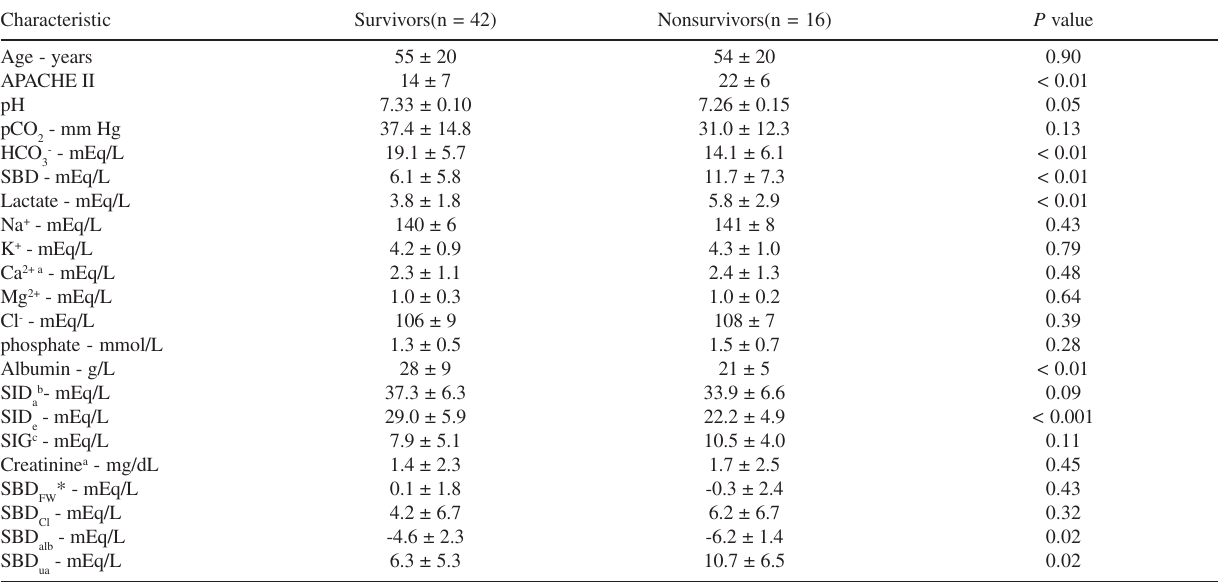
Table 3 - Comparison between survivors and nonsurvivors (mean ± SD)